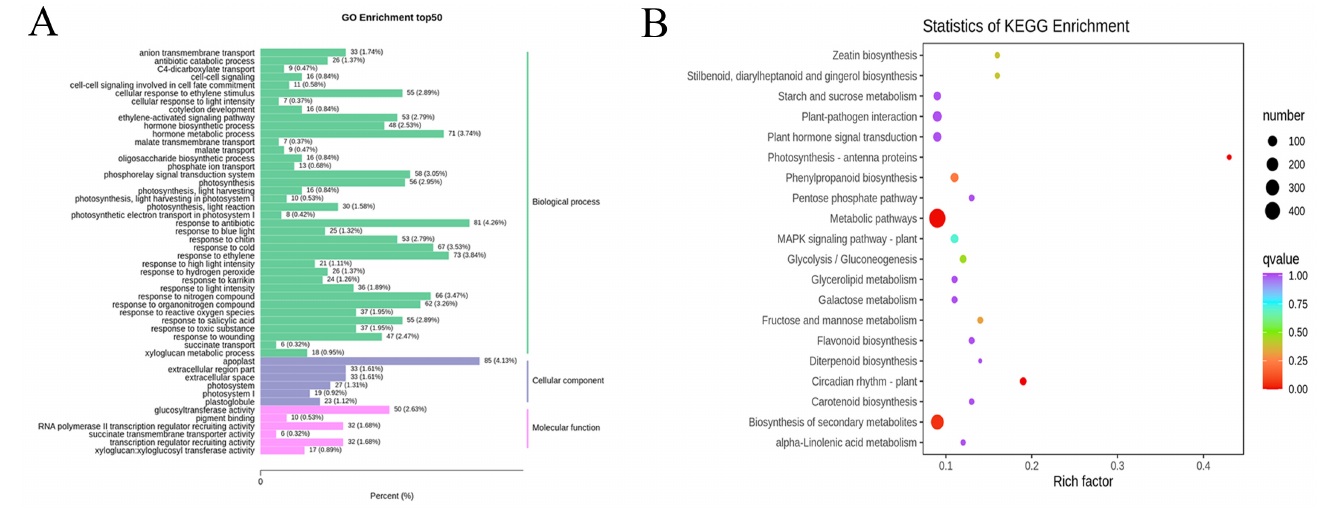
Figure 5. Functional annotation of DEGs after treated with 6 h cold stimulus. ( A ) The GO classification of DEGs. ( B ) Significantly enriched KEGG pathways analysis of DEGs.